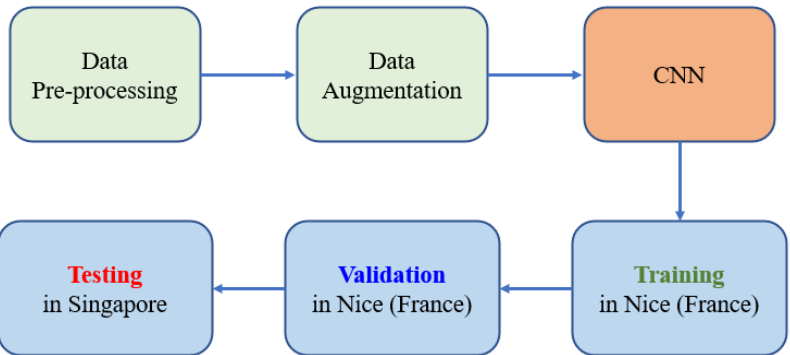
Figure 2. Flowchart of the methodology.